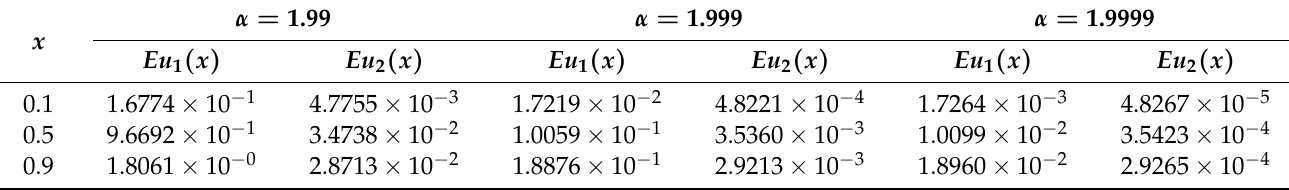
Table 4. Absolute errors of u 1 ( x ) and u 2 ( x ) at different orders α for Example